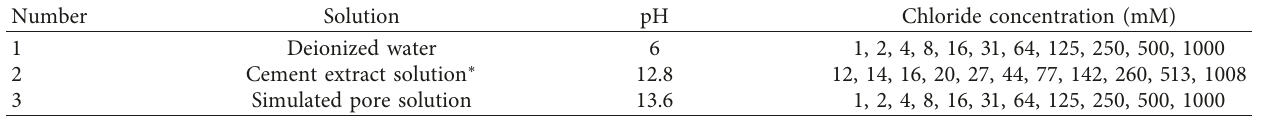
Table 1: Solutions for calibration of the chloride sensors.